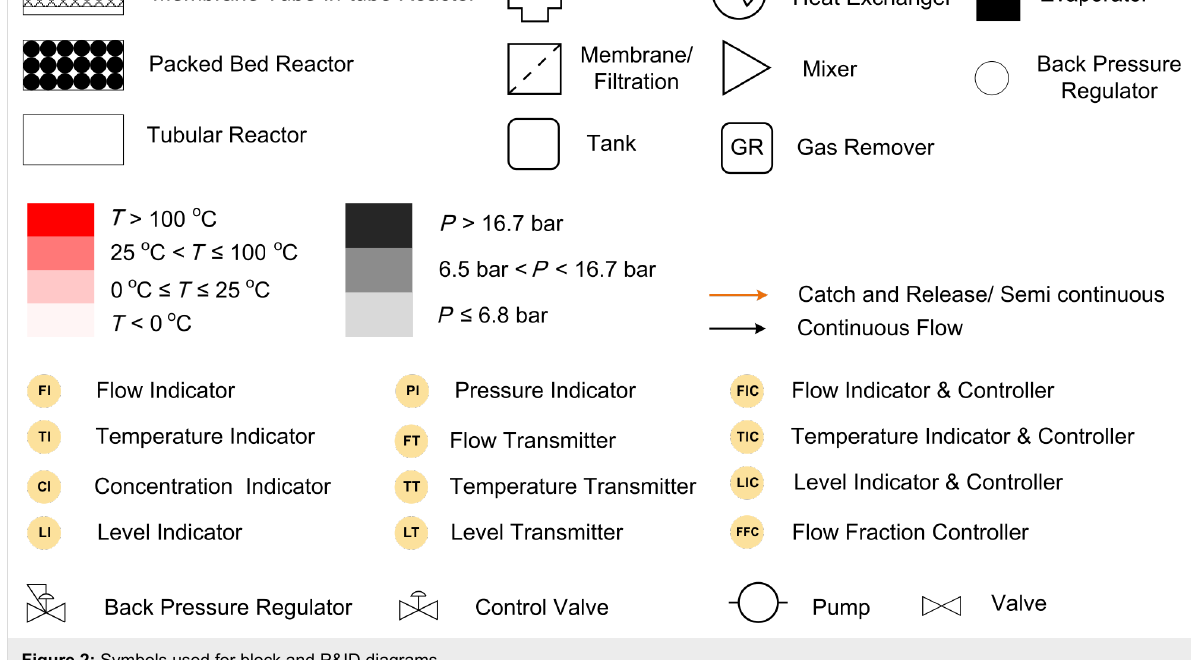
Figure 2: Symbols used for block and P&ID